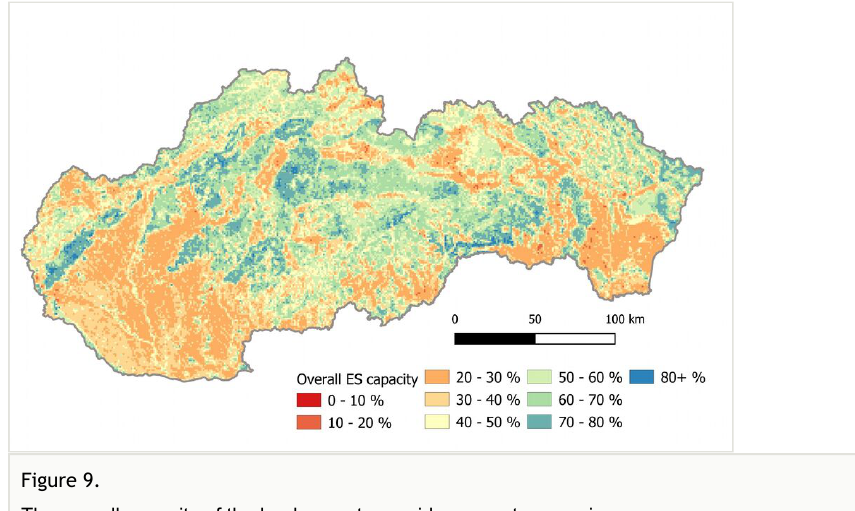
The overall capacity of the landscape to provide ecosystem services.